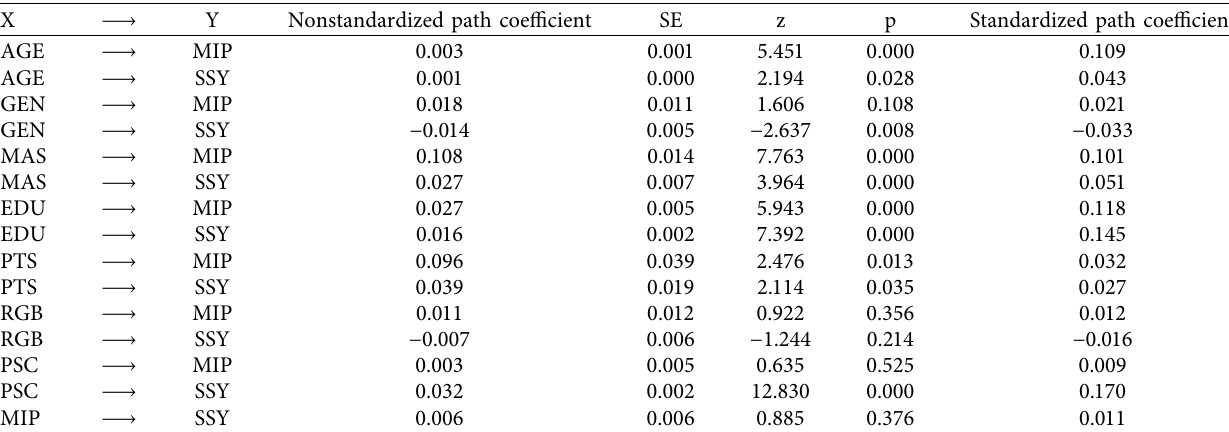
Table 3: Estimated results of the impact of medical insurance on sense of security